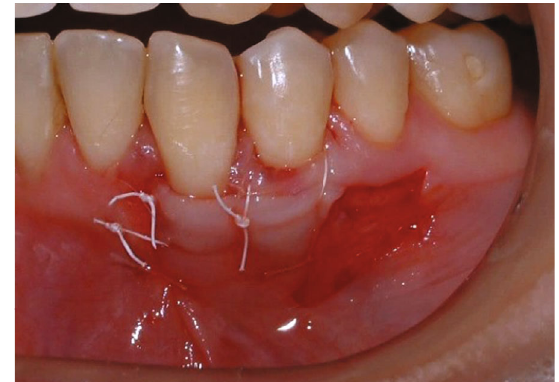
Figure 8: The 4.5mm of keratinized tissue was moved laterally to the receptor area and sutured at CEJ. Note that the collar of 1.5 mm of keratinized tissue was maintained in its original